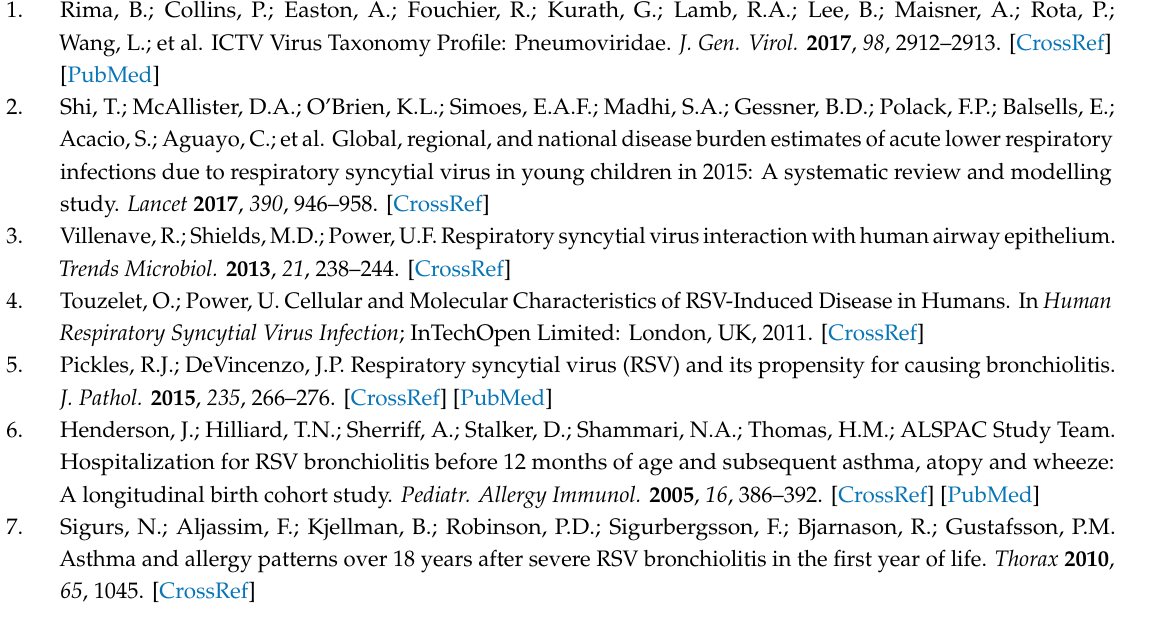
Figure S1: Time course analysis of TNFR1 blockade during RSV infection demonstrates reduced neutrophil activation early in infection; Figure S2: Cytokine and chemokine analysis of 40, 80, and 160 µ g anti-TNFR1 during RSV infection; Figure S3: Cytokine and chemokine analysis of 40, 80, and 160 µ g anti-TNFR2 during RSV infection; Figure S4: Blockade of TNFR1 does not modulate cell death in RSV